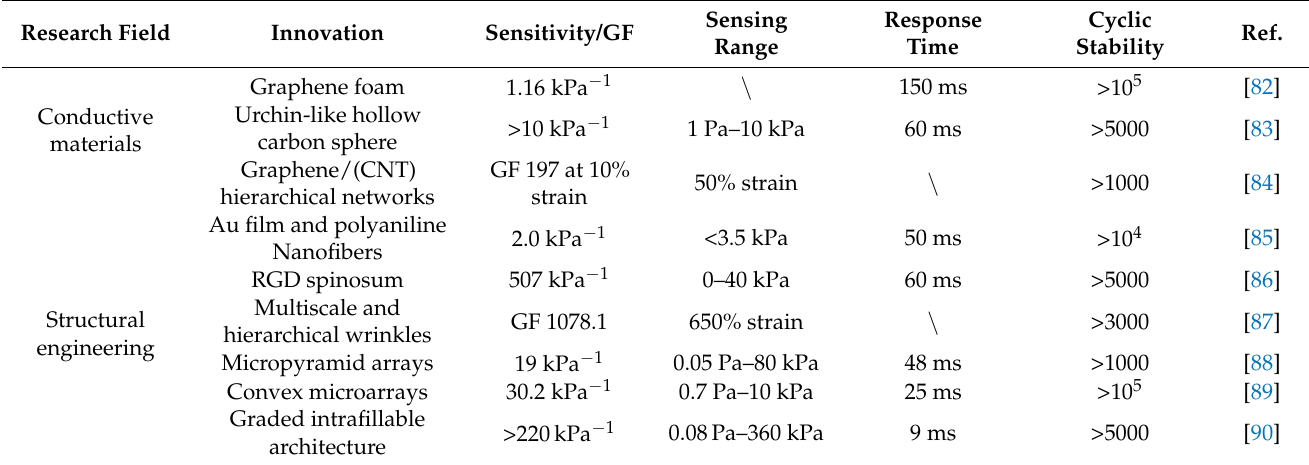
Table 2. Summary of the performance of some flexible pressure/strain